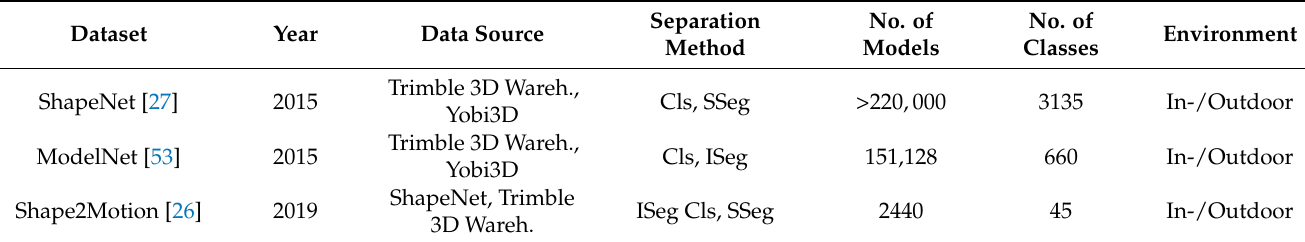
Table 1. Synthetic datasets with year of publication, data source, separation method (classification (Cls), semantic segmentation (SSeg) and instance segmentation (ISeg)), number of models, number of classes and